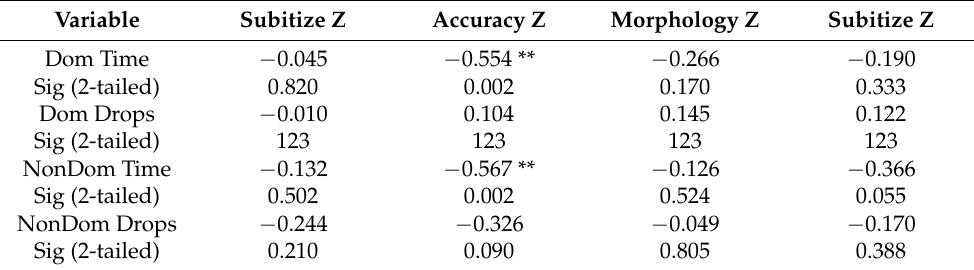
Table 10. Correlations between Gestural Ability and Grooved Pegboard Performance (n = 28).